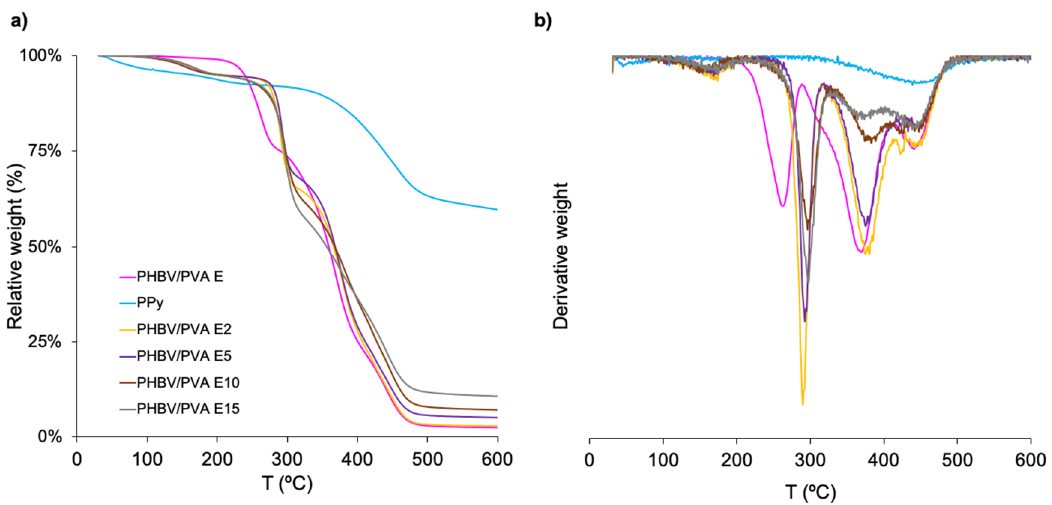
Figure 9. Thermogravimetry results of neat PPy nanoparticles and semi-IPN PHBV/PVA E with different percentages of PPy nanoparticles. PHBV/PVA E is included as reference. ( a ) Relative weight and ( b ) first derivative of the weight loss as a function of temperature (DTG).